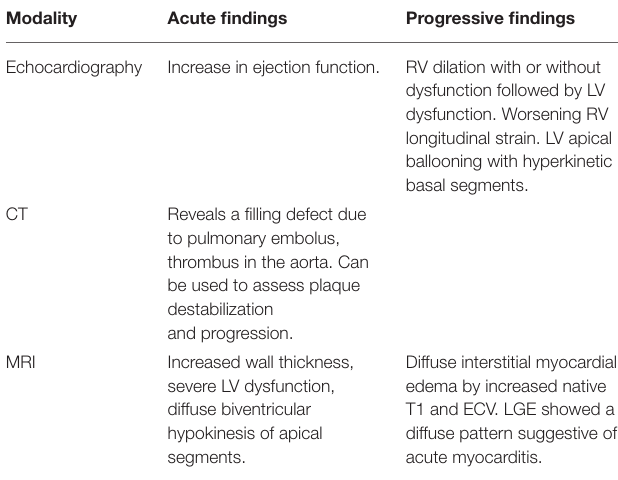
TABLE 2 | Cardiovascular imaging features of